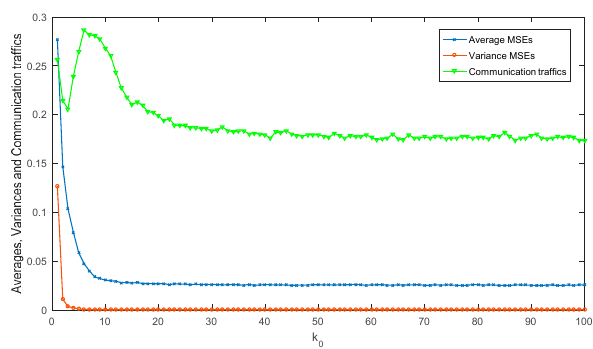
Figure 5. The statistical data of MSEs and communication traffics with different k 0 .